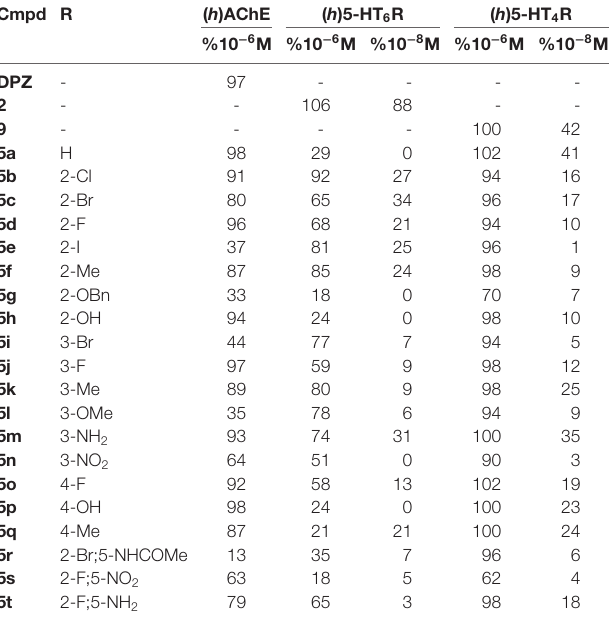
TABLE 1 | ( h )AChE inhibitory activity, ( h )5-HT 6 R and ( h )5-HT 4 R affinity for DPZ, 2 , 9 and compounds 5a–t (% inhibition at 10 − 6 M, 10 − 8 M and 10 − 8 M, respectively). Cmpd